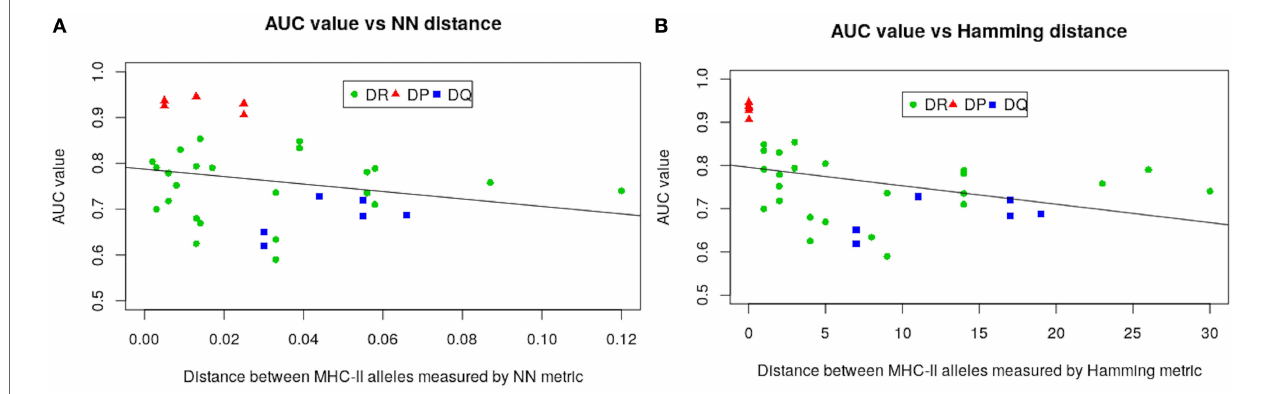
FIGURE 4 | Regression analysis of AUC values from the LOO approach as function of: (A) nearest-neighbor and (B) Hamming distances. Negative slope lines in both graphs obtained by the least square fit method, with p-values 0.185 and 0.0.033 for both metrics, respectively. These lines and p-values associated with were produced using glm2 package in R (45).